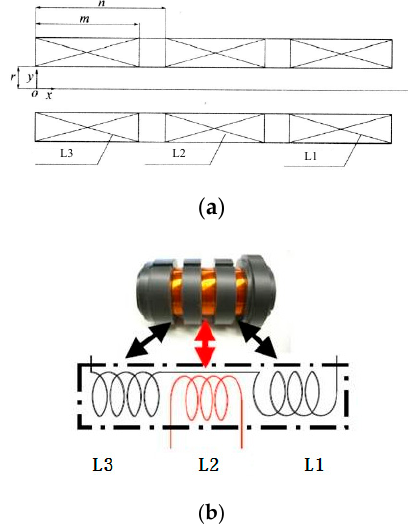
Figure 2. Illustration of the three-coil winding inductance. ( a ) Relative position indication of the winding. ( b ) Skeleton picture of the three-coil winding.